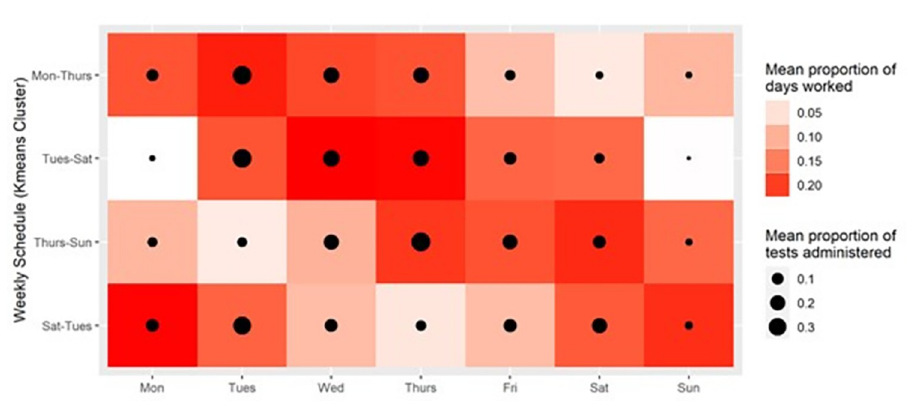
Fig 2. Staff work and testing schedules. Four typical weekly work schedules (y-axis) were identified among CDCR custody staff. These include a Monday to Thursday workweek (21% of staff), a Tuesday to Saturday workweek (33% of staff), a Thursday to Sunday workweek (22% of staff), and a Saturday to Tuesday workweek (24% of staff). The red shading shows the mean proportion of staff workdays that consist of a particular day of the week (x-axis; i.e. darker shades of red indicate that staff with the specified schedule more commonly worked on that day). The size of the black circles represents the mean proportion of the total number of tests administered to each group that were given on the specified